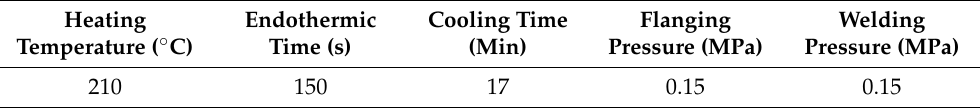
Table 1. Welding parameters of the HDPE pipe butt fusion joints